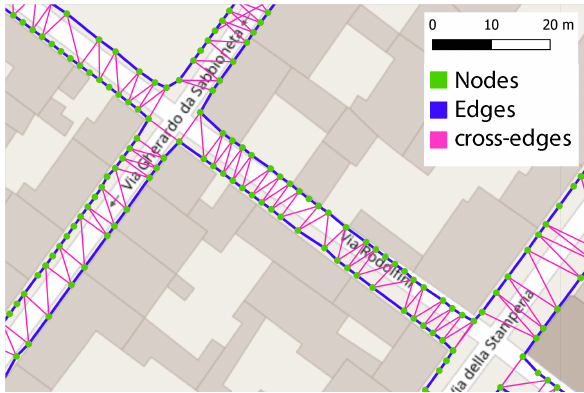
Figure 5. A portion of the city of Sabbioneta, green circles are the nodes, representing the sidewalks segments, blue lines are the edges connecting the sidewalks along the sidewalk path, and purple lines are edges that connects sidewalk nodes crossing the road, considering the possibility for pedestrian to cross every- where inside the historic center of the city.